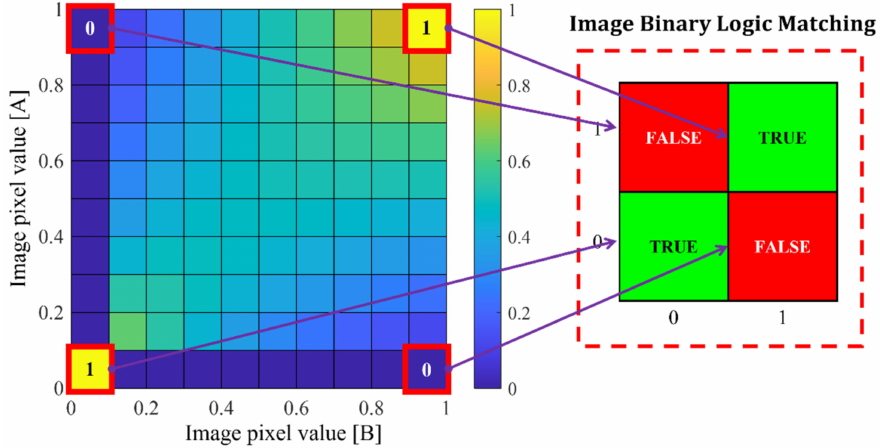
Figure 5. Heatmap analysis of BLM algorithm and its visualization for computing pixel